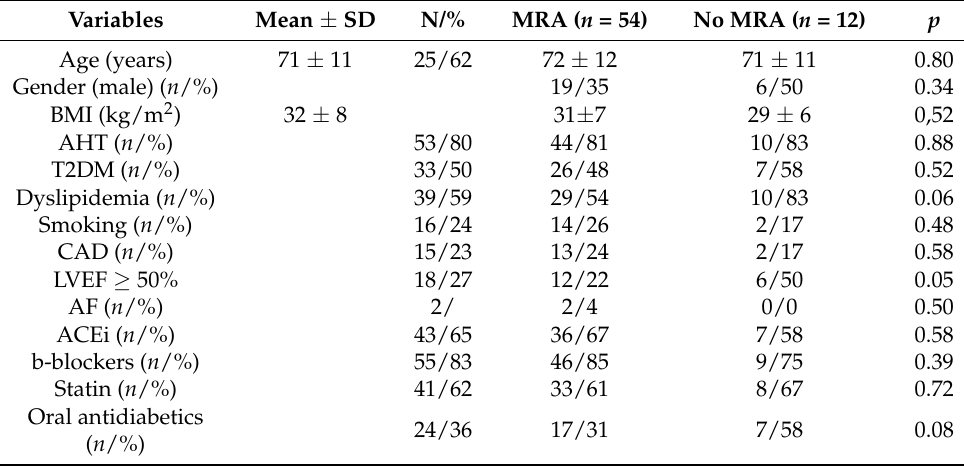
Table 4. Clinical characteristics of patients with